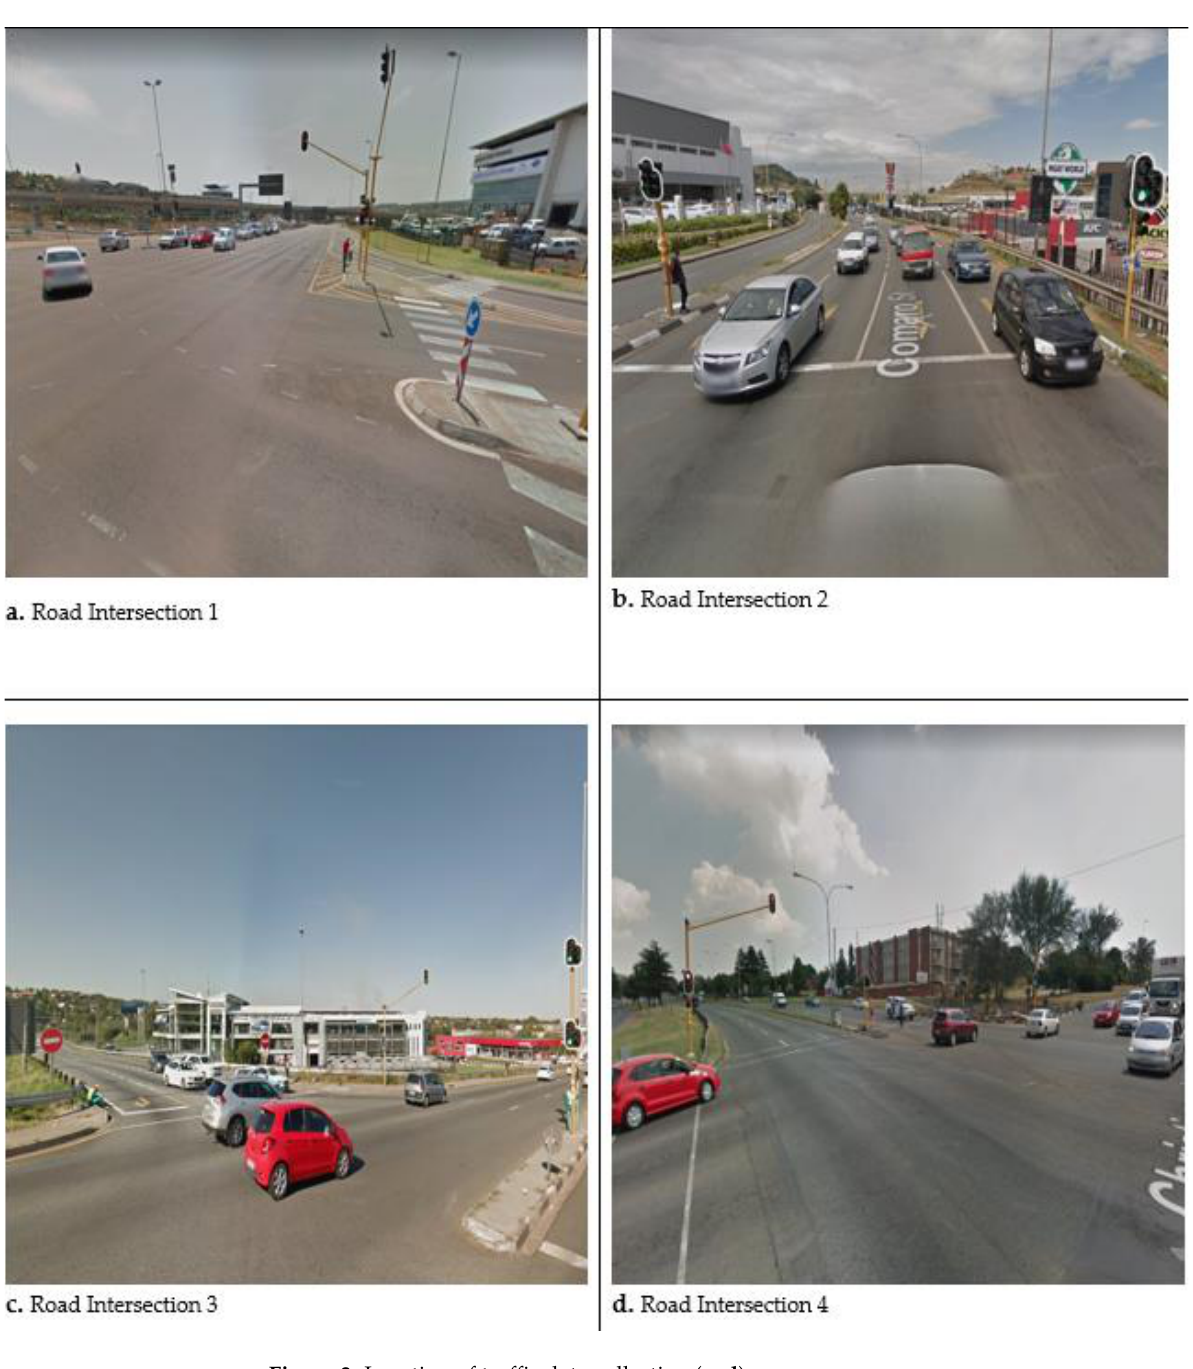
Traffic flow data were collected for fifteen days between 15 July 2019 and 29